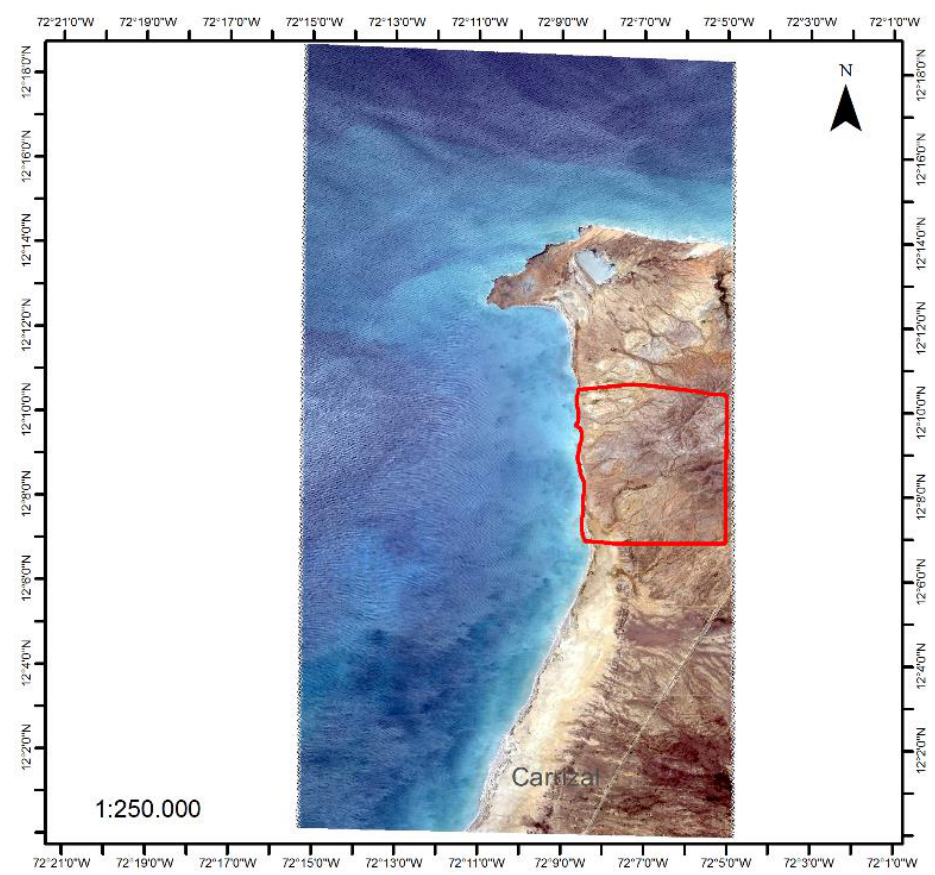
Figure 4. QuickBird image 15 March 2007 of Cabo de la Vela.